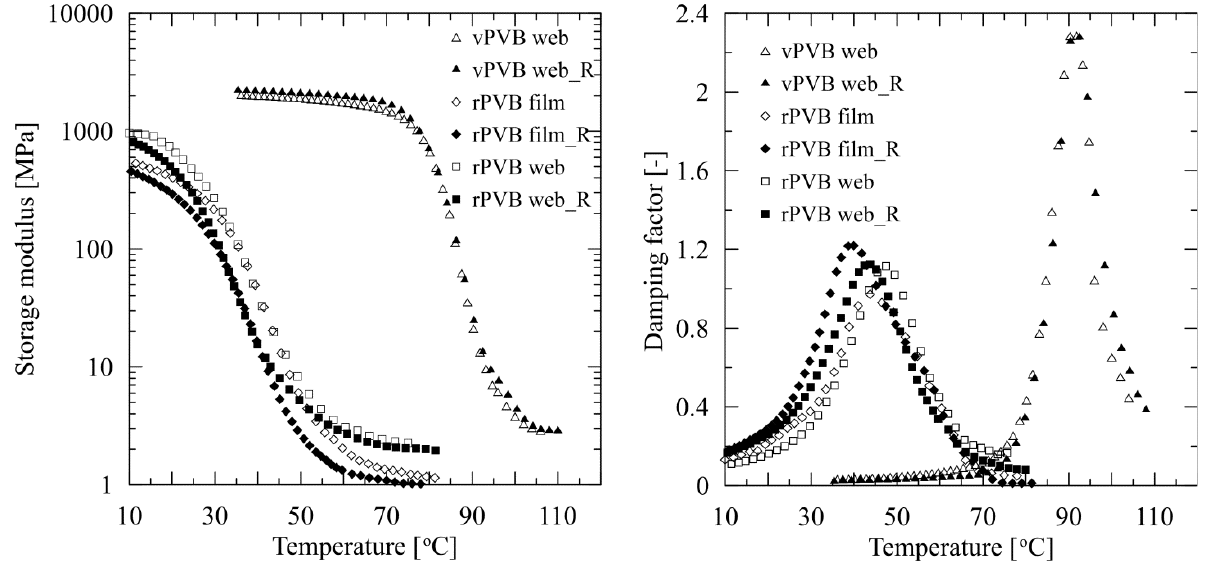
Figure 14. Comparison of temperature dependent behavior of storage modulus ( left ) and damping factor (tan delta) ( right ) of rPVB compressed films and electrospun webs.